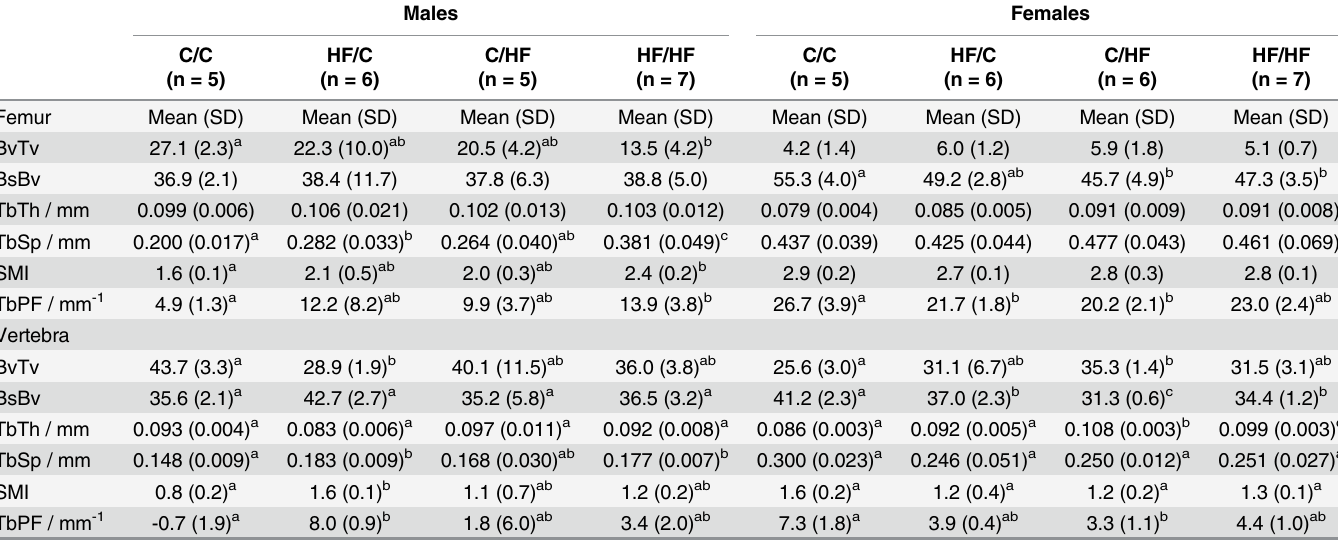
Table 2. Bone structural parameters for femur and 3 rd lumbar vertebra from 30 week old